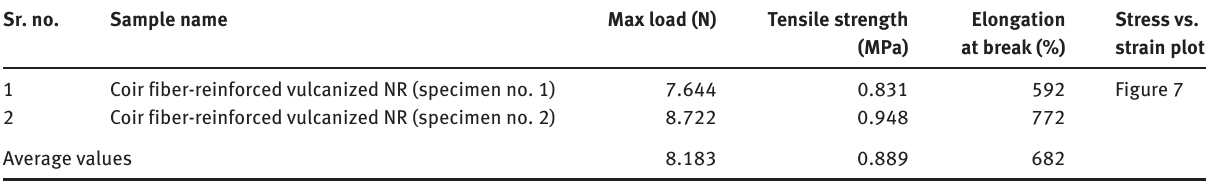
Table 5: Mechanical properties of coir fiber-reinforced vulcanized NR composite after cold resistance at − 60 ° C for 8 h. Sr.